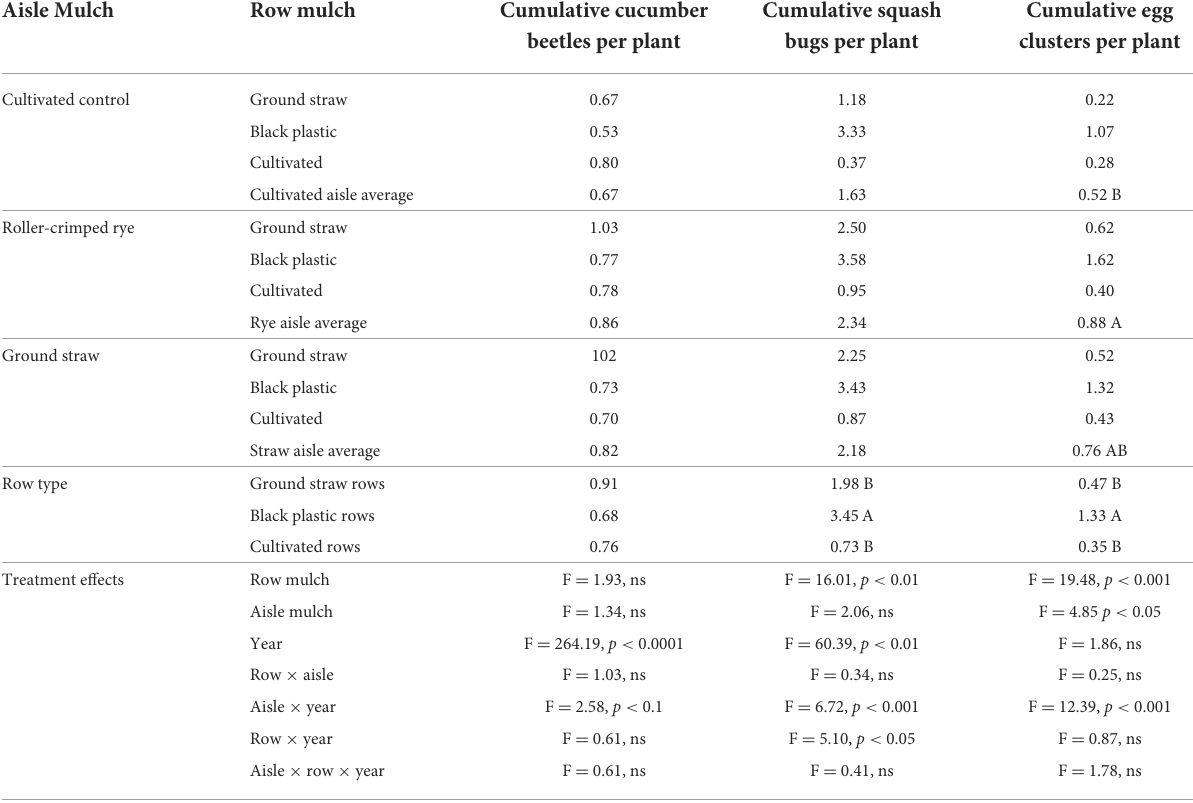
TABLE 4 Average (2018 and 2019) cumulative cucumber beetle, squash bugs and egg cluster counts by aisle mulch treatment.